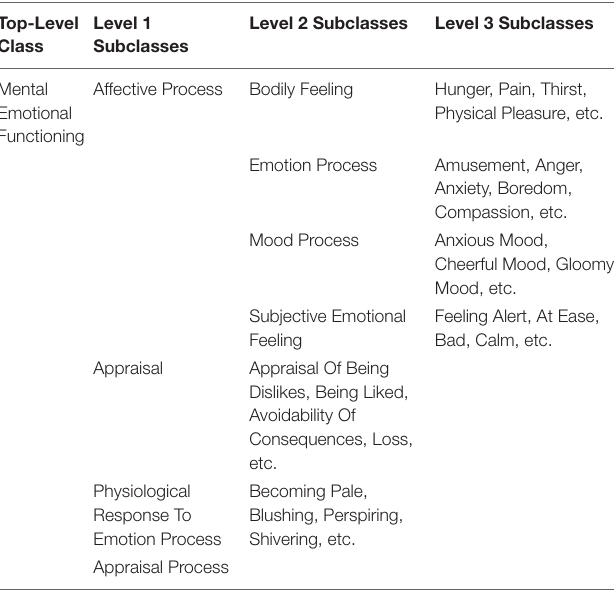
TABLE 3 | The main classes and subclasses involved in mental emotional functioning, as incorporated from the Emotions Ontology. Top-Level